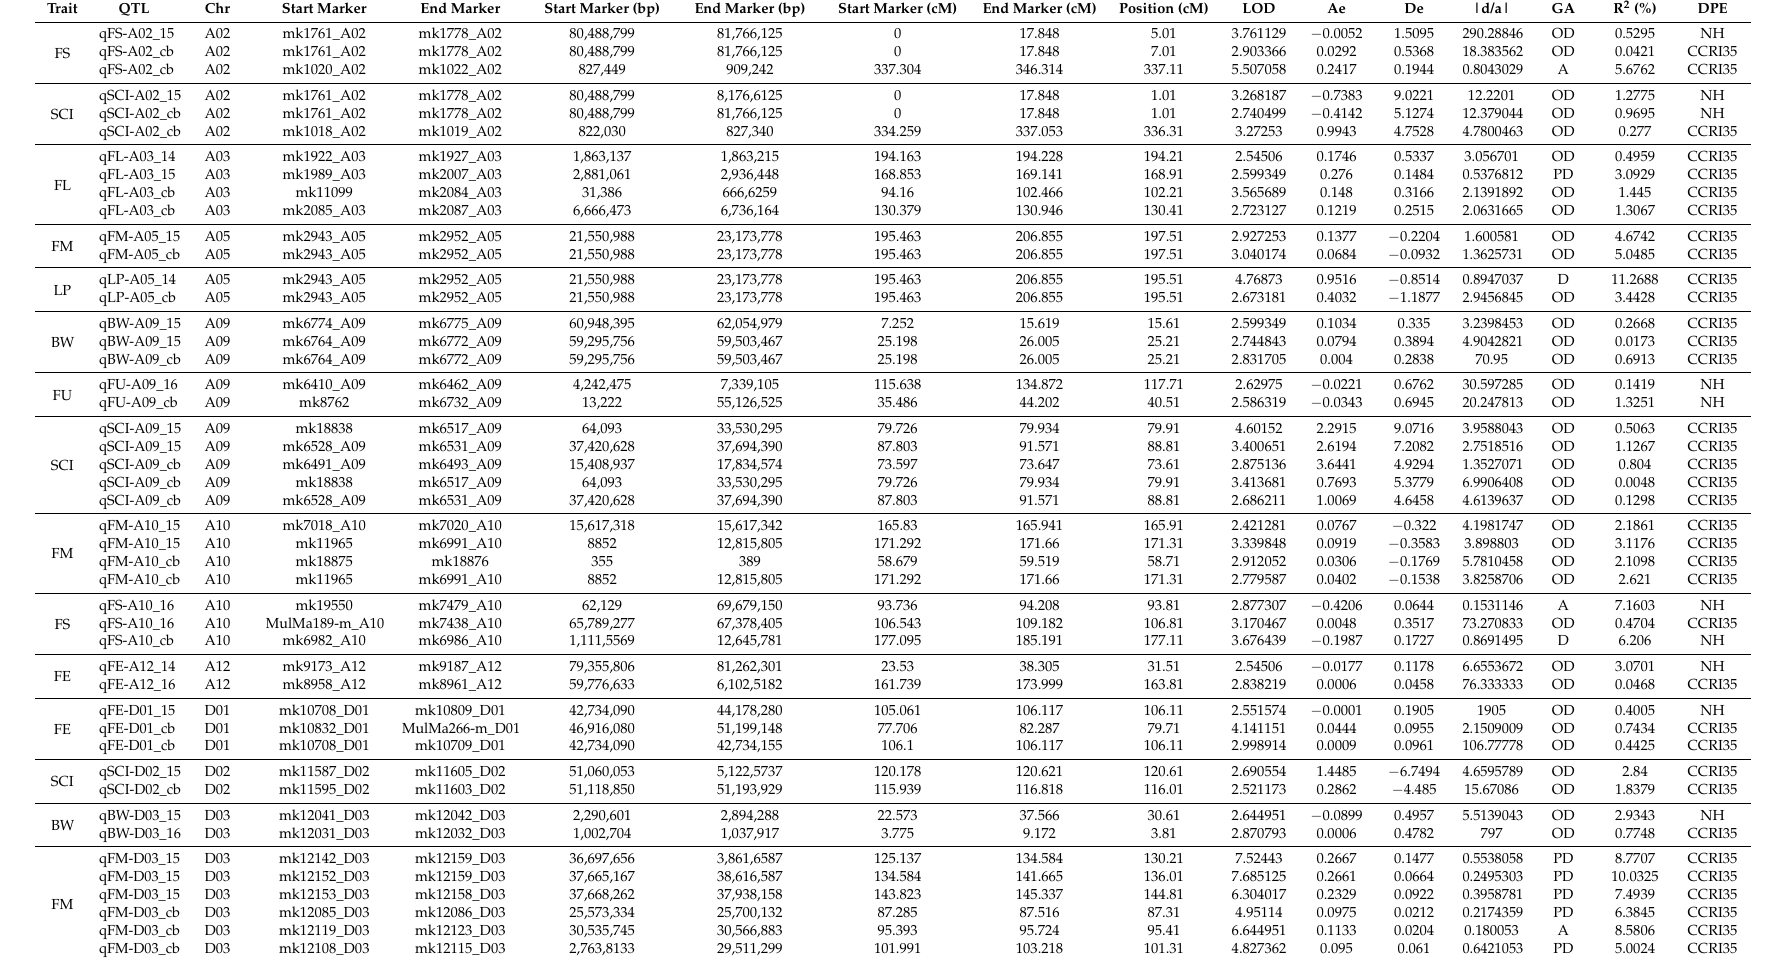
Table 3. Consistent QTLs for fiber quality and yield related traits identified in this